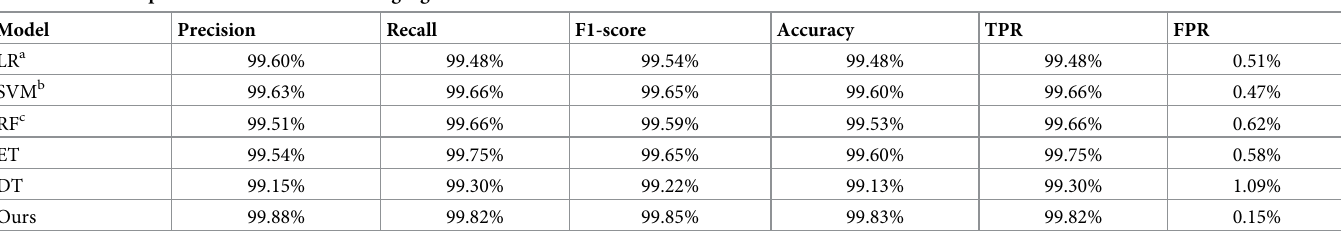
Table 14. The comparison with machine learning